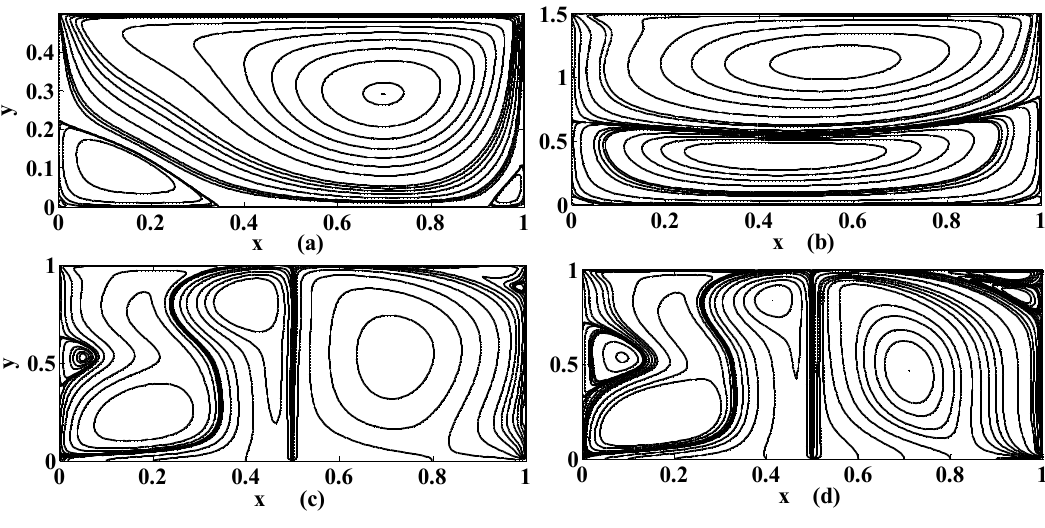
(cid:110) (cid:111) α γ = { 0, 0.5 } ; ( b ) p ,